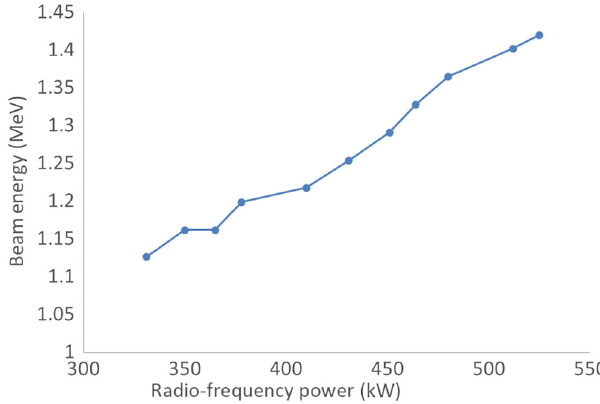
FIG. 23. Relative beam momentum spread of the beam spectra main peak as a function of the beam